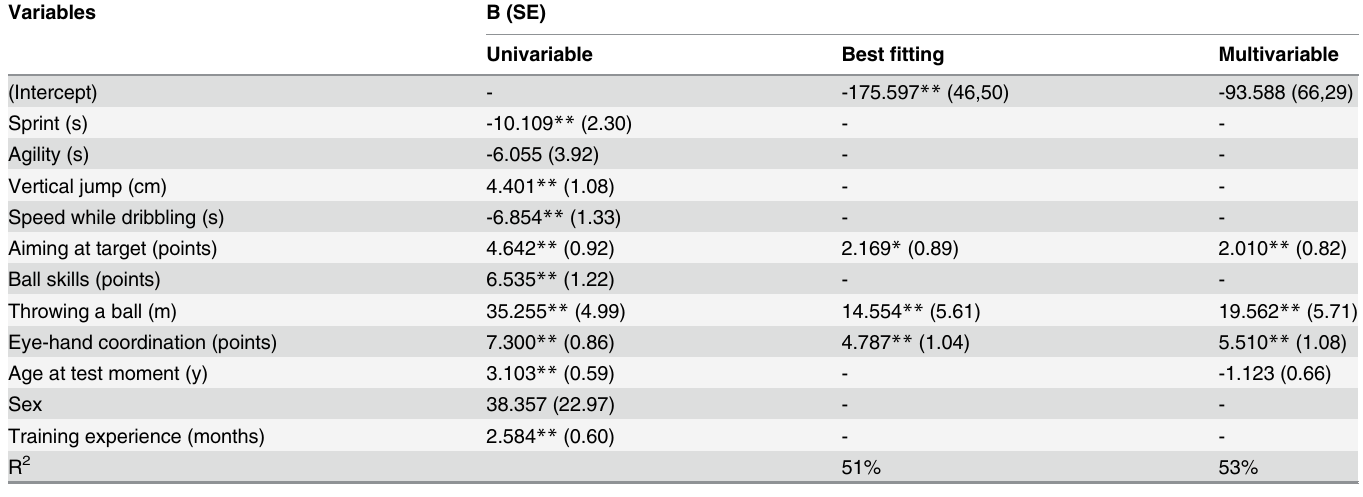
Table 3. Predictive validity results for competition performance (univariable and multivariable generalized estimated equations analyses, n =